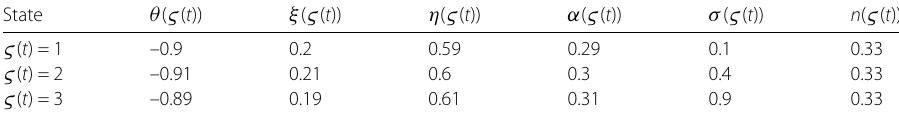
Table 4 Parameter values under finite regime switching of model (4)